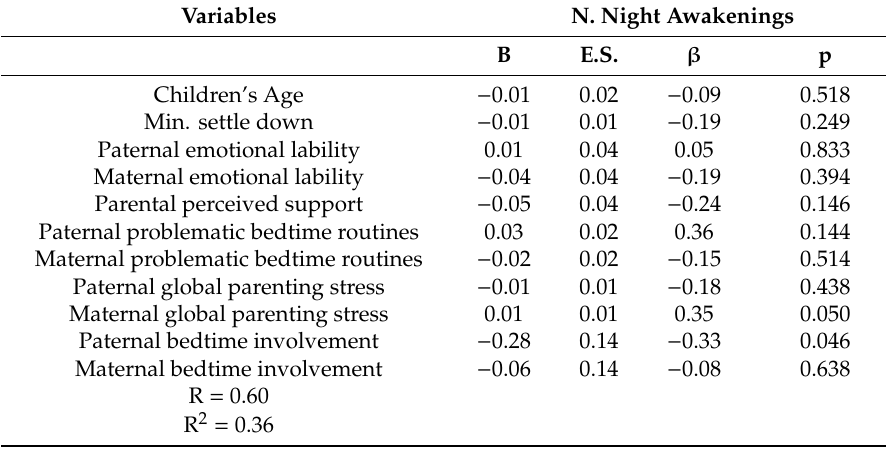
Table 4. Regression coe ffi cients of predictors of the number of night awakenings. Variables N. Night Awakenings B Children’s